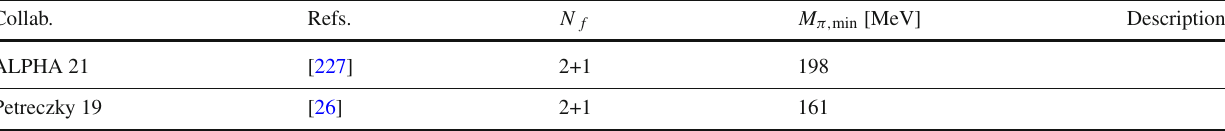
Table 90 Chiral extrapolation/minimum pion mass in the determinations of m c with N f = 2 + 1 quark flavours Collab.